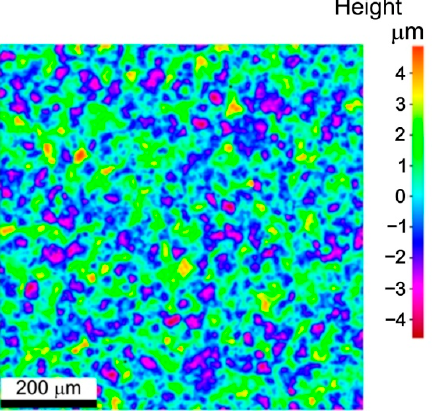
Figure 1. Topography of the as-received Grade 5 titanium alloy surface. To determine the microhardness of the sheet material, a NEXUS 4303 tester (IN- NOVATEST Europe BV, Maastricht, The Netherlands) with a Vickers pyramidal dia- mond tip was used. The microhardness HV0.3 was measured in nine locations on the sheet surface, evenly distributed over the width and length of the sample (Figure 2). To limit the influence of roughness on the microhardness value, the sheet surfaces were polished. Average values of the three measurements of microhardness along each line (Figure 2) showed a random character with no clear directional properties.